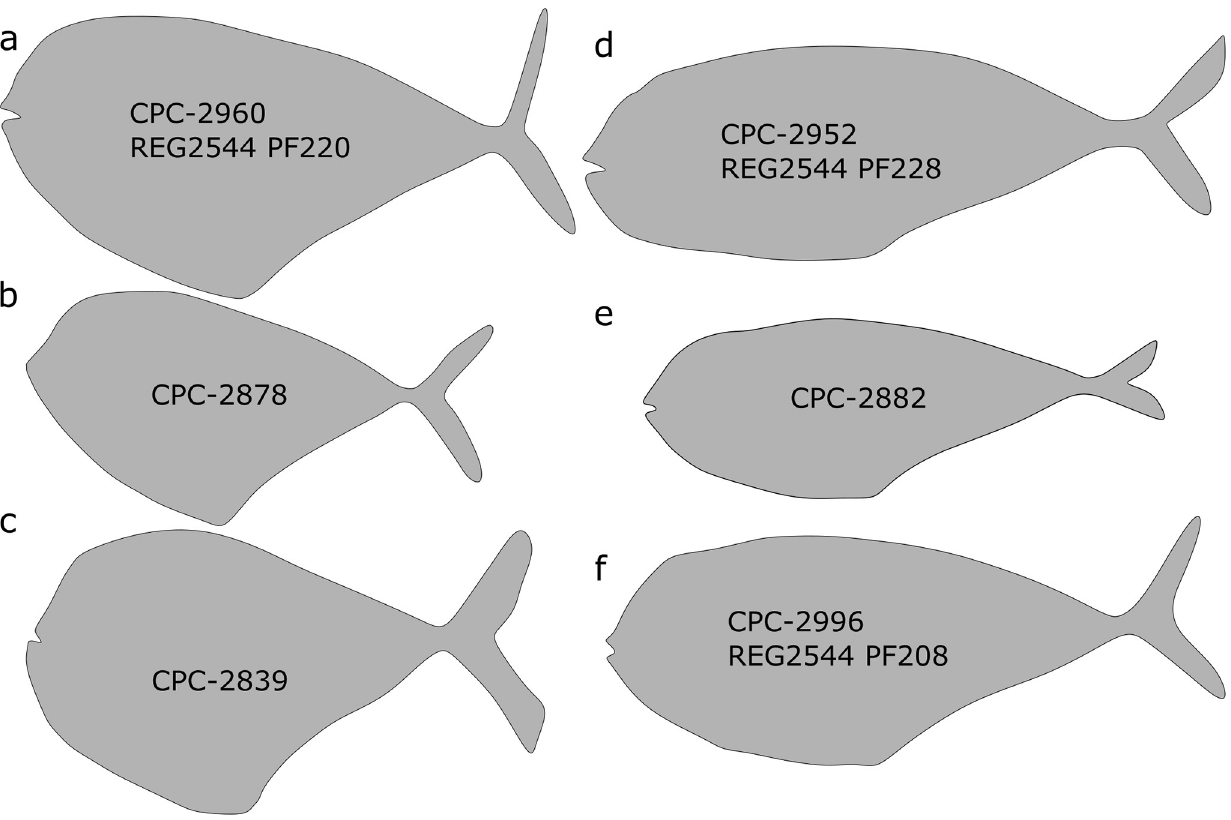
Fig 4. Body shape types documented in T . formosa . Diamond-shaped individuals are deeply keeled (A—C) while torpedo-shaped individuals show a streamlined body outline (D—F). The specimen collection numbers are placed inside each shape.